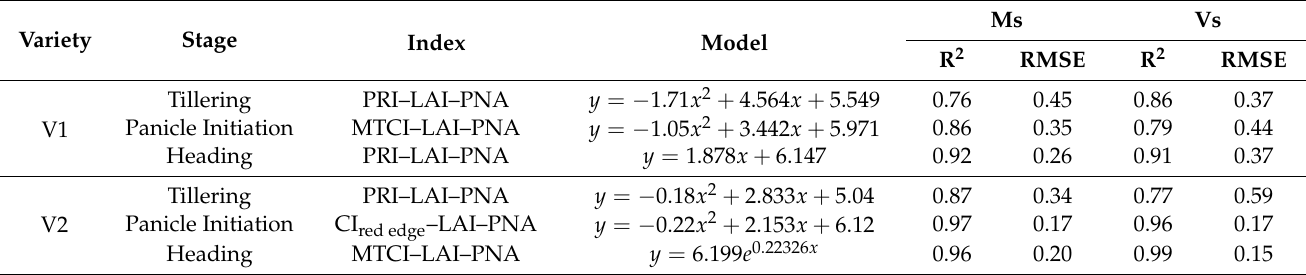
Table 10. Three-dimensional rice grain protein content (GPC) monitoring index models and their accuracy ( n =